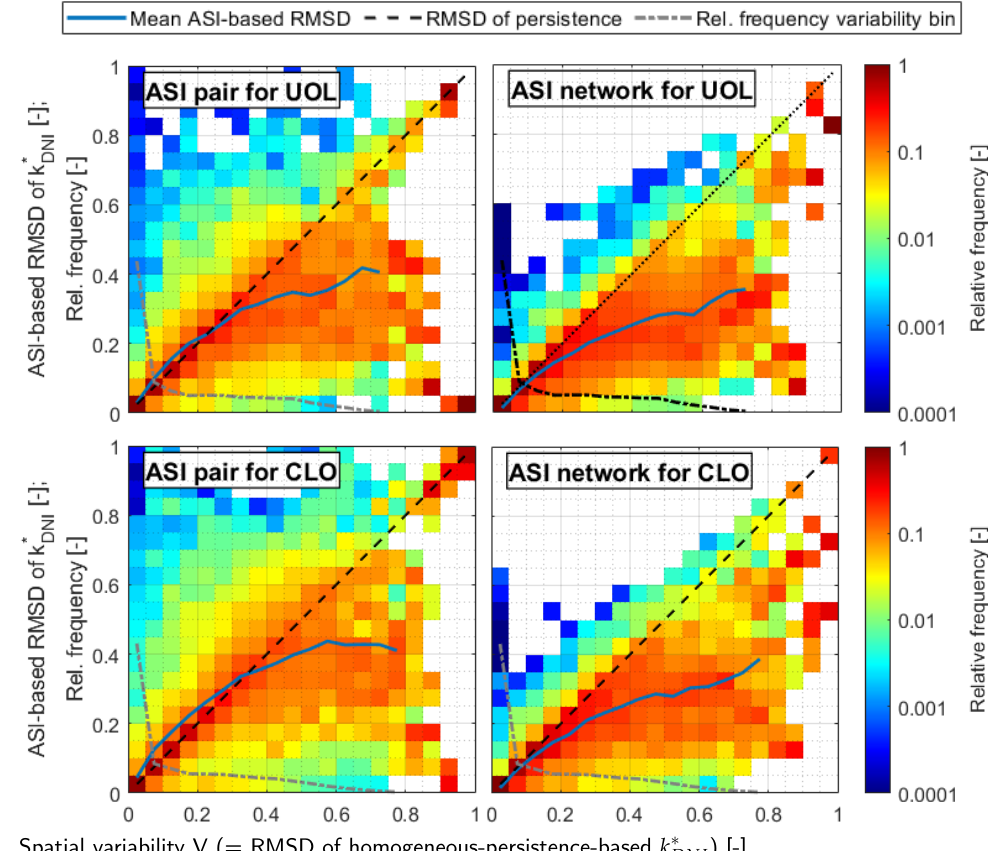
Figure 12. The scatter-density plots compare the RMSD of k ∗ received from an ASI-based analysis DNI to that received from homogeneous persistence. The 92 day dataset is split into floating 25-min windows. For each window, the RMSDs of the ASI-based and homogeneous persistence analysis are calculated. The periods are classified by the RMSD of homogeneous persistence. Per bin of the RMSD from homogeneous persistence (i.e., per column in the plot), the distribution (i.e., rows in the plot, color coded) and the mean value (blue line) of the ASI-based RMSD is evaluated. The top row evaluates station UOL. The bottom row evaluates CLO. Estimations based on homogeneous persistence (black dashed main diagonal in each panel), ASI pair ( left panels ) and ASI network ( right panels ) are shown. In addition, the relative frequency of the variability bins is plotted (grey, dash-dotted). Note that high relative frequencies of the RMSD further below the main diagonal (i.e., lower RMSD values of the ASI system) indicate a higher accuracy of the respective ASI-based